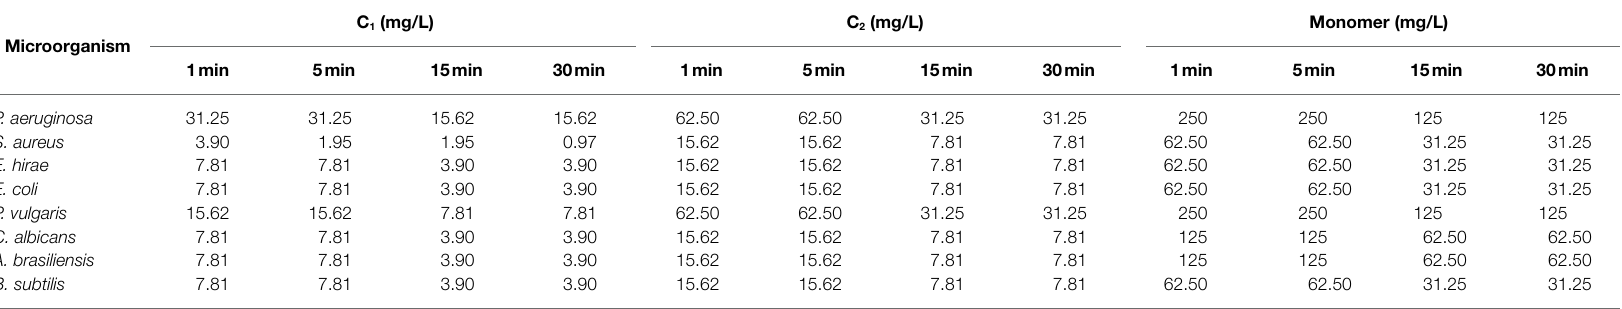
TABLE 5 | Bactericidal concentrations resulting in a ≥ 5 logarithmic reduction in the quantitative suspension test.